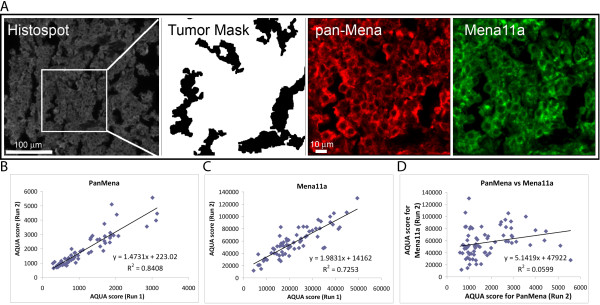
Development of a robust and reproducible MQIF assay to assess Menacalc. A. Representative tumor histospot with Pancytokeratin staining used to define the tumor mask, pan-Mena (red) and Mena11a (green) showing a cytoplasmic staining pattern. Scale bar is shown at the left bottom of the panels. B, C. Reproducibility of MQIF Menacalc assay. Linear regression between two independent runs of pan-Mena (B) and Mena11a (C) multiplexed on serial sections of an index TMA have a high correlation (R2 = 0.84 and 0.73 respectively). D. Linear regression between pan-Mena and Mena11a on an index TMA slide shows no correlation (R2 = 0.06).